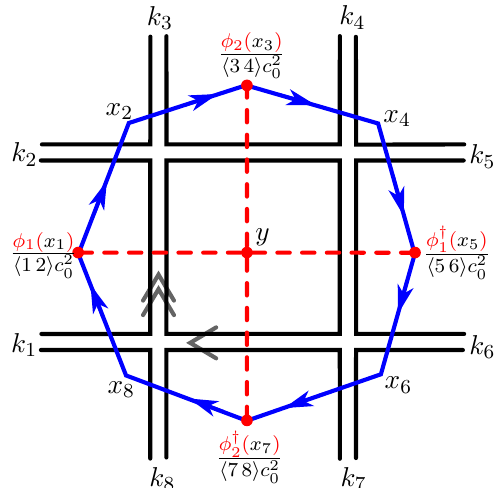
Figure 3 . The leading contribution to the eight-point amplitude of f (cid:30) 1 ( k 1 ) ; (cid:30) 1 ( k 2 ) ; (cid:30) 2 ( k 3 ) ; (cid:30) 2 ( k 4 ) ; (cid:30) y ( k 5 ) ; (cid:30) y ( k 6 ) ; (cid:30) y ( k 7 ) ; (cid:30) y ( k 8 ) g in the (cid:12)shnet model. Here black lines correspond to the propagators 1 1 2 2 in the double line notation and the grey arrows indicates the (cid:13)ow of the two conserved U(1) charges. In the dual space one (cid:12)nds a null octagon Wilson loop, represented by the blue line. It consists of four scalars inserted at f x 1 ; x 3 ; x 5 ; x 7 g . The dashed red lines represent the single Feynman